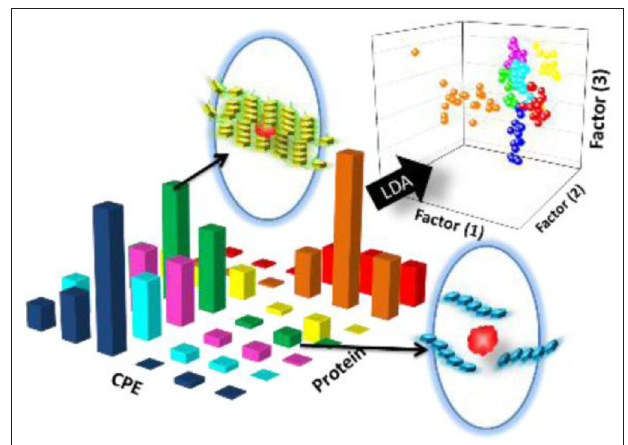
FIGURE 1 | Schematic representation of the CPEs-based sensor array for the discrimination of proteins. Reprinted from Wu and Schanze (2014) with